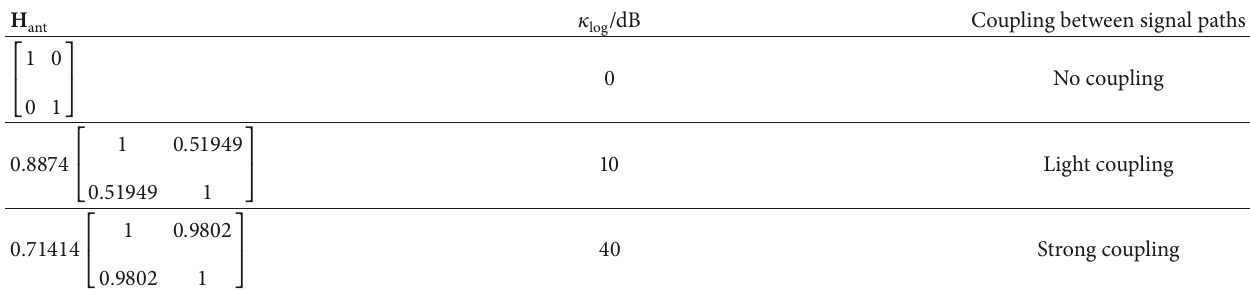
Table 1: Antenna matrices with different coupling and condition